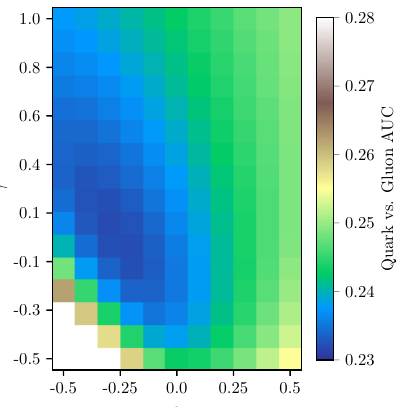
= (cid:28) (cid:11) (cid:28) (cid:13) (cid:28) 3 . The AUC for the 1 2 O